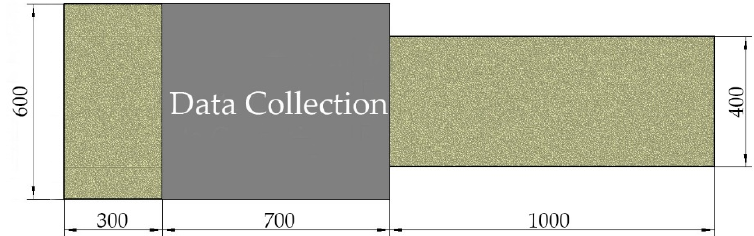
Figure 6. Schematic diagram of virtual earth warehouse.